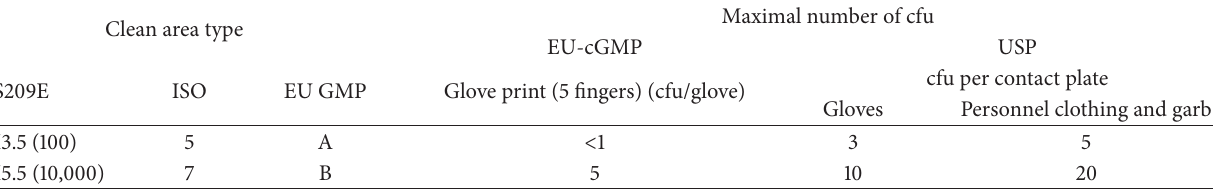
Table 8: Recommended limits for viable airborne particles on personnel according to FDA-cGMP, EU-GMP, and USP. Clean area